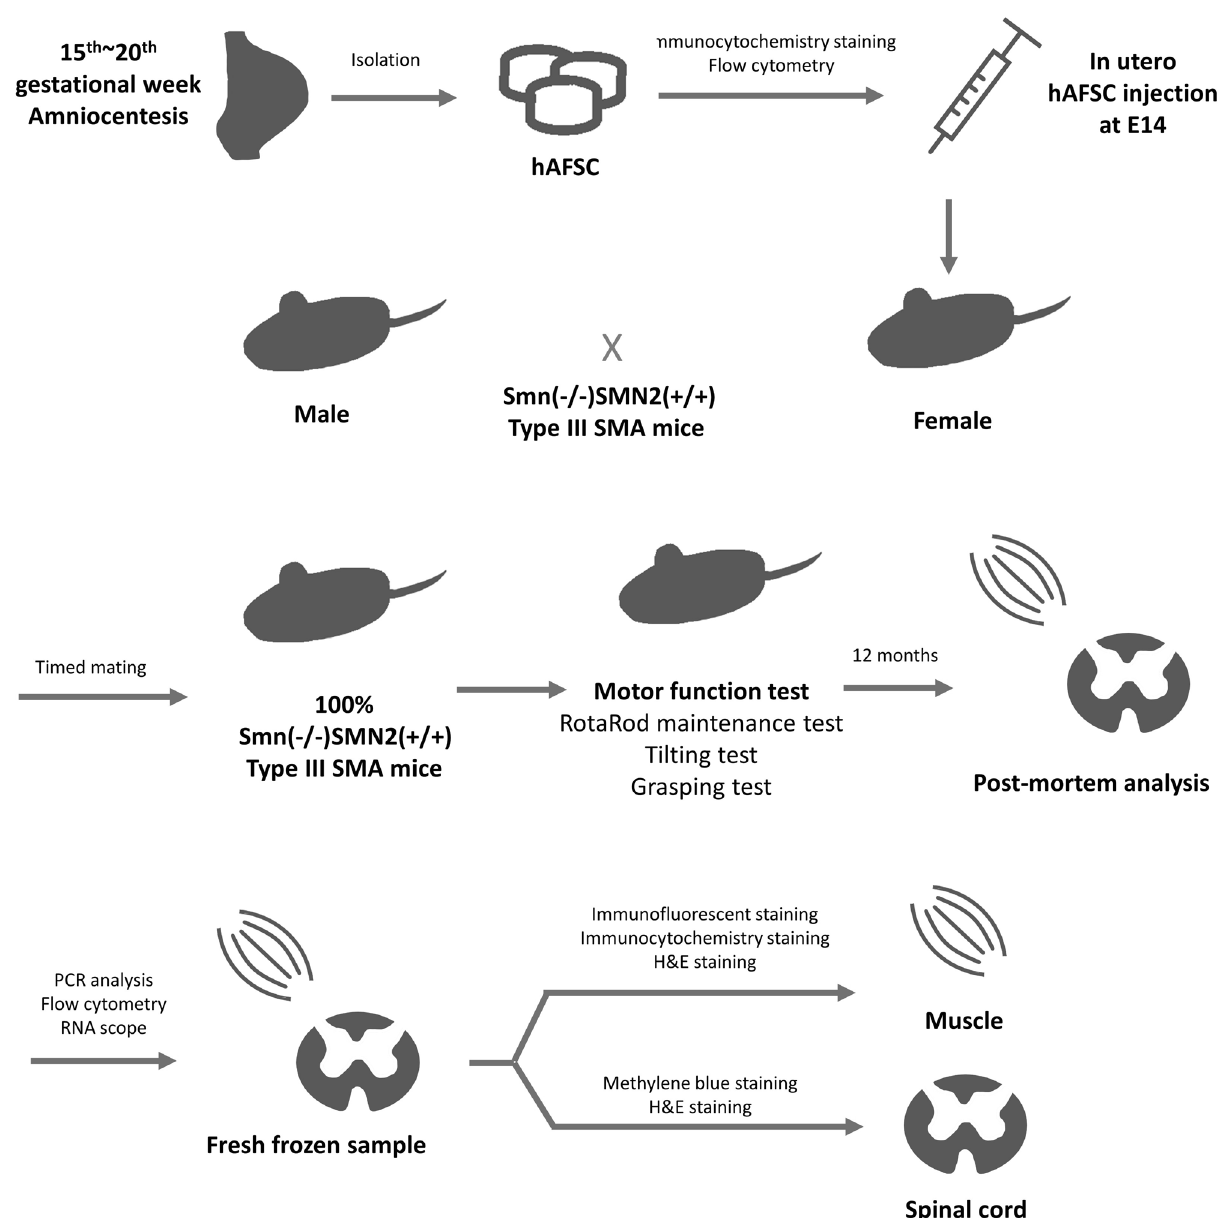
Figure 3. The design of experiment. Mating of male and female Smn(−/−)SMN2(+ / +) type III mice achieved 100% success. 1 × 10 5 hAFSCs were injected in utero at embryonic day 14. hAFSC human amniotic fluid stem cell, SMA spinal muscle